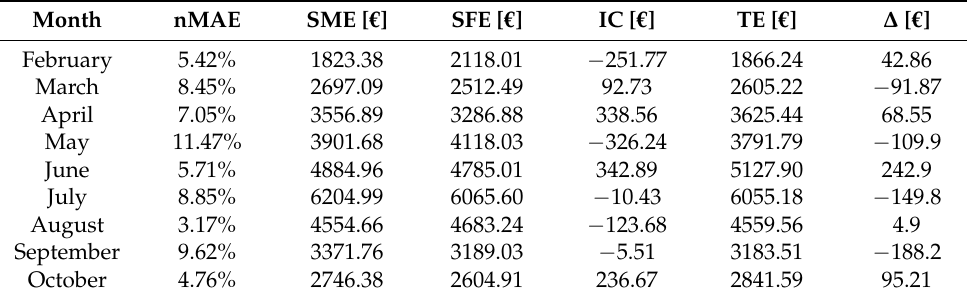
Table 2. Economic evaluation of imbalances.